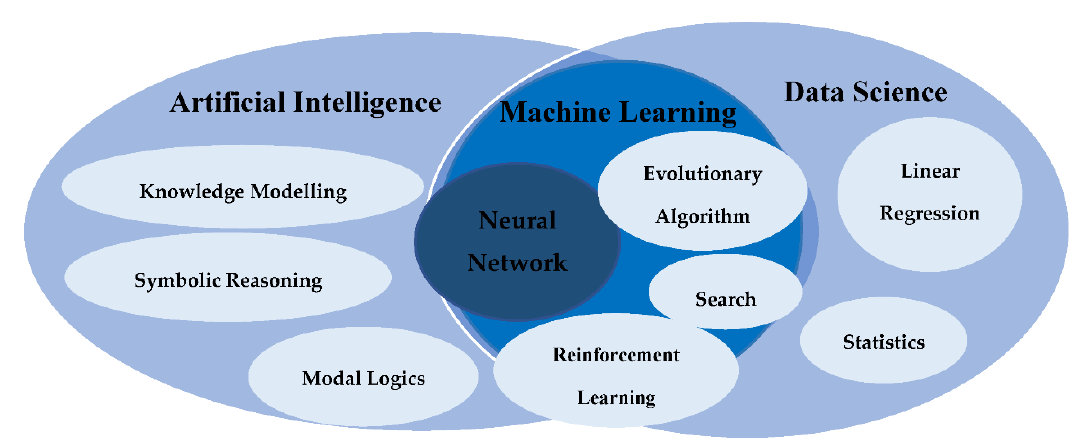
Figure 4. Data processing in ICT.